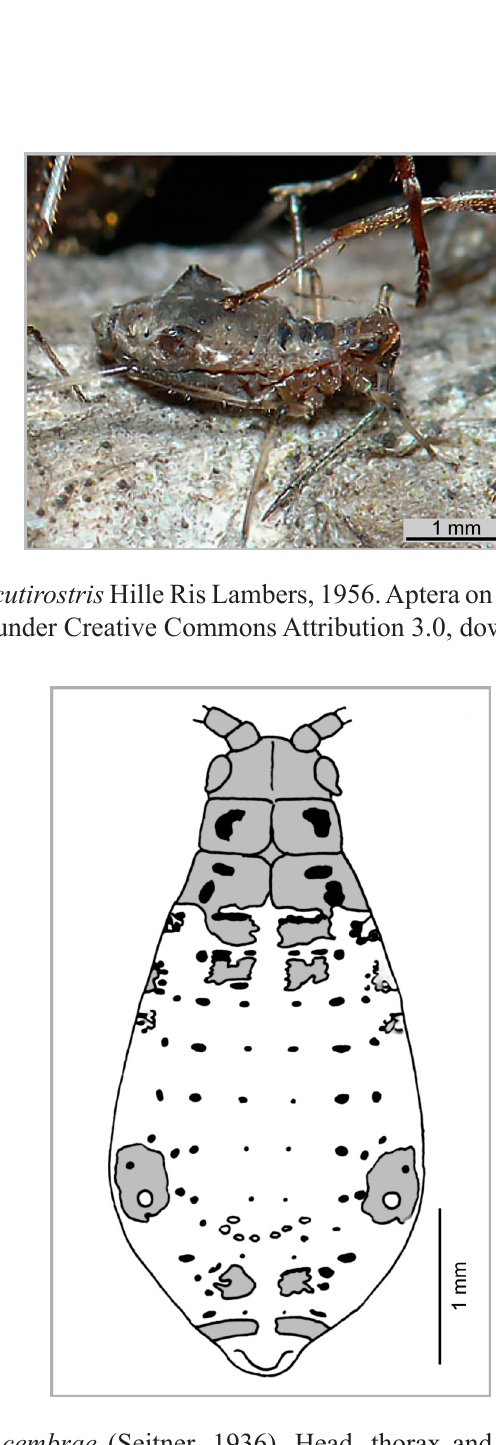
Fig. 91. Cinara (Cinara) cembrae (Seitner, 1936). Head, thorax and abdomen (after Pintera 1966,